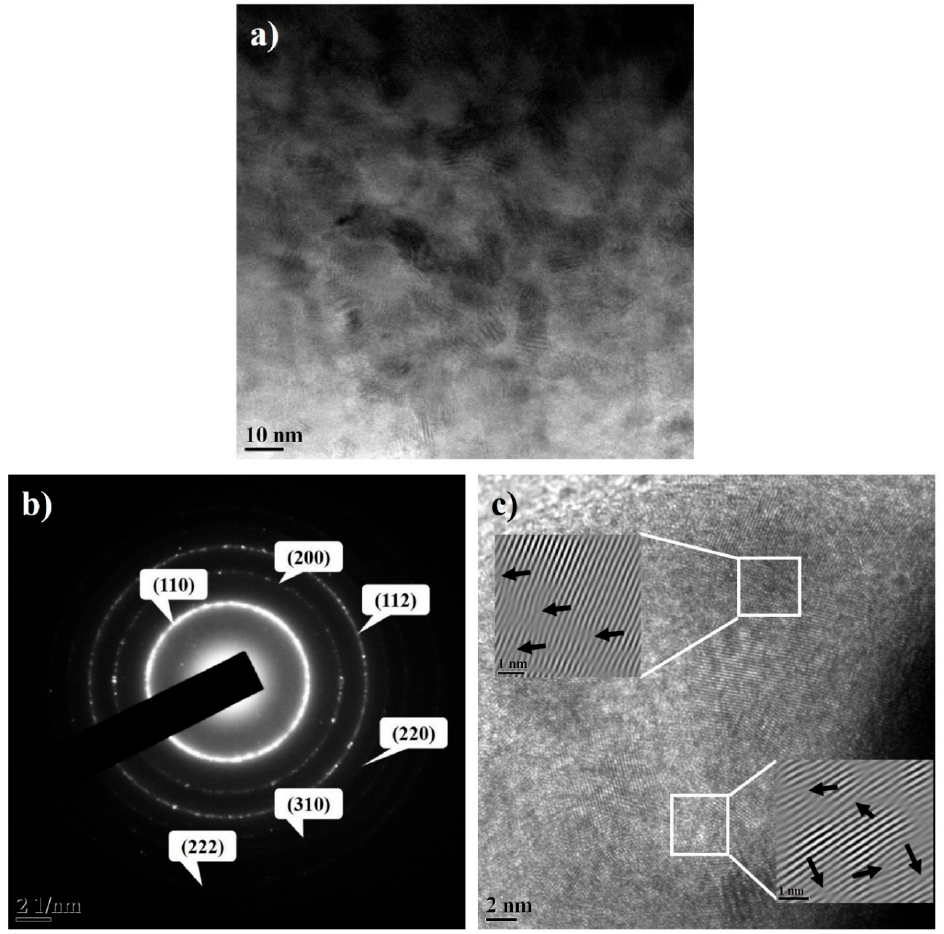
Figure 3. ( a ) TEM; ( b ) SAED; and ( c ) HRTEM images of 20 h milled Fe–10Cr–3Al powder. Edge dislocations are observed in the inverse fast Fourier transform (FFT) image (inset).